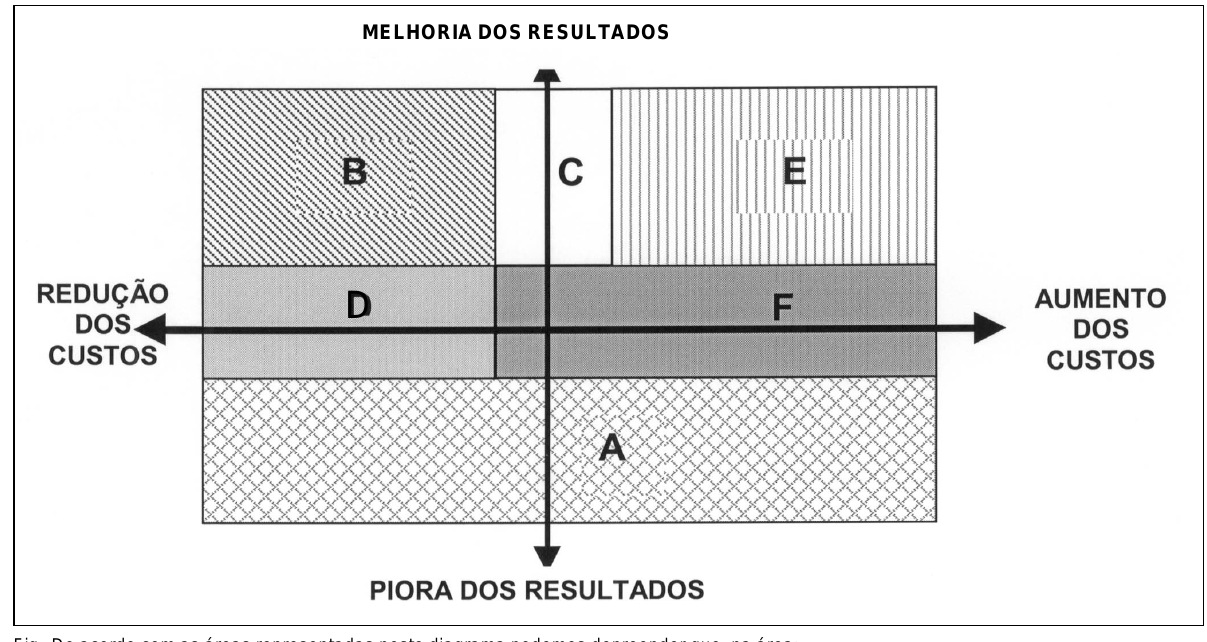
Fig. De acordo com as áreas representadas neste diagrama podemos depreender que, na área: